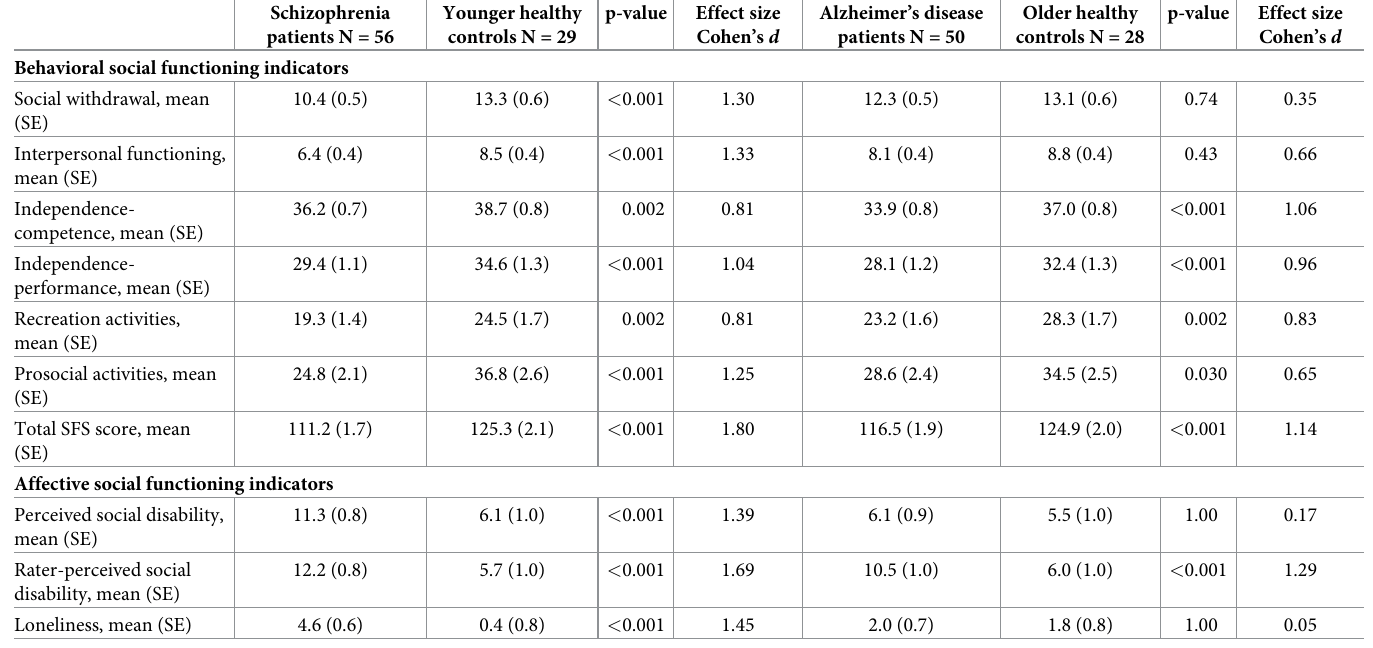
Table 3. Mean adjusted † social functioning scores across disorders compared with healthy controls.